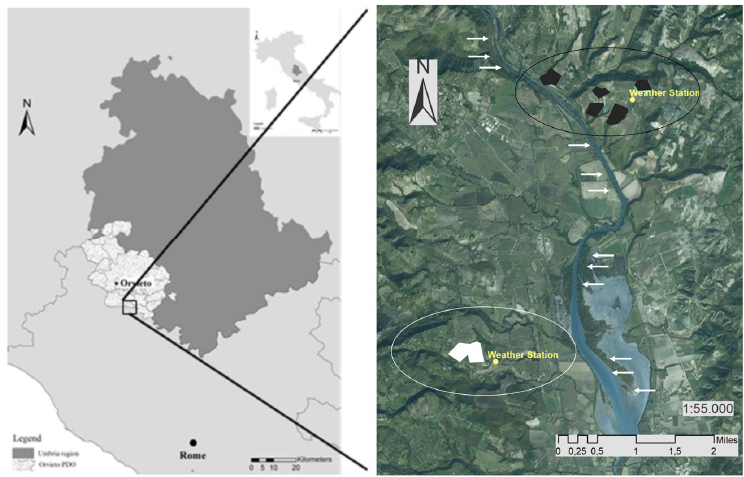
Figure 1. Umbria region (central Italy) and the study grape ‐ wine growing area, the ‘Orvieto’ Protected Designation of Origin (PDO) (left). Localization of the two wineries and tested vineyards (right). White polygons, vineyards of white varieties (Grechetto di Orvieto and Chardonnay), winery of the western sub ‐ area; black polygons, vineyards of red varieties (Aleatico, Merlot, Cabernet sauvignon and C. franc, Sangiovese), winery of the eastern sub ‐ area; yellow circles, position of the on ‐ farm weather stations in each winery; white ellipse, position of the western sub ‐ areas of the PDO; and black ellipse, position of the eastern sub ‐ area of the PDO. Arrows, Tiber River.